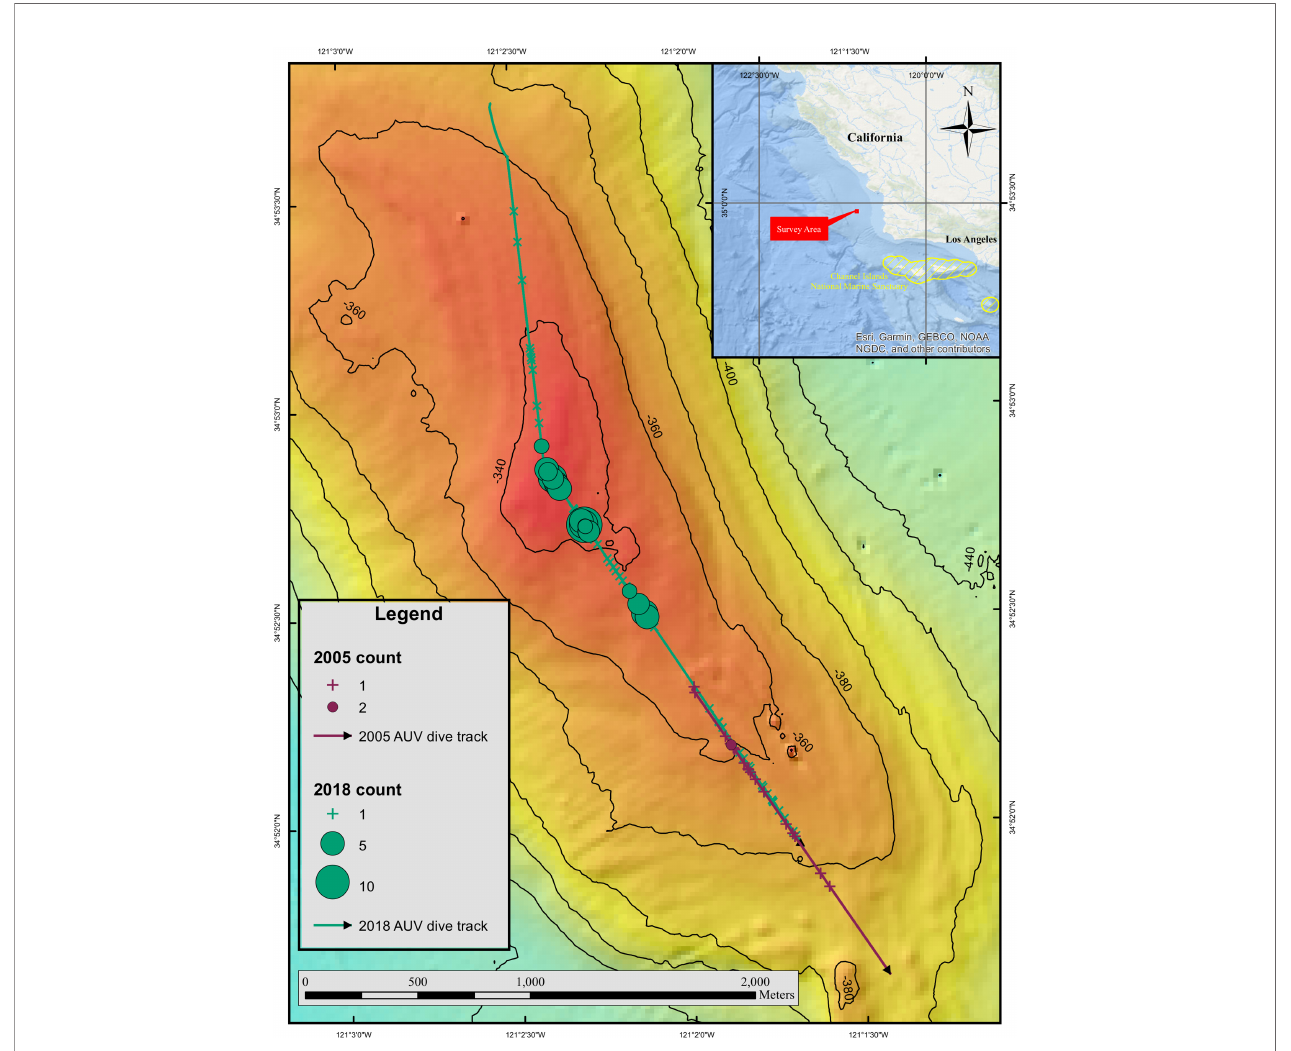
FIGURE 1 | Inset map shows the location of the area where high densities of petrale sole were observed. Close up map shows the feature where the petrale sole were located and distribution of fi sh along the AUV dive track. The 2005 dive track is represented by a purple line and the 2018 dive track is shown in green. Crosses represent locations where only a single petrale sole was present in an image, whereas circles highlight images with more than one individual. The size of the circles is related to the number of fi sh observed in an image and smaller circles represent fewer fi sh than larger